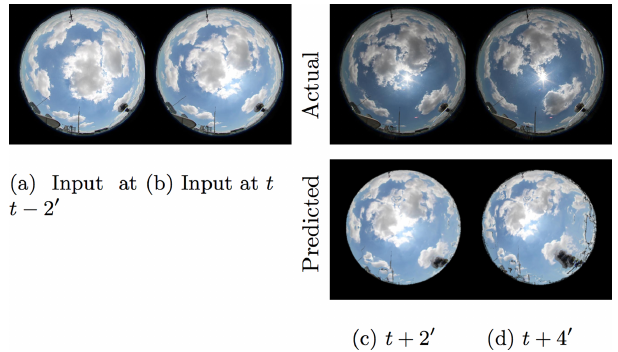
Figure 14. Prediction of sky–cloud image using the optical flow technique.